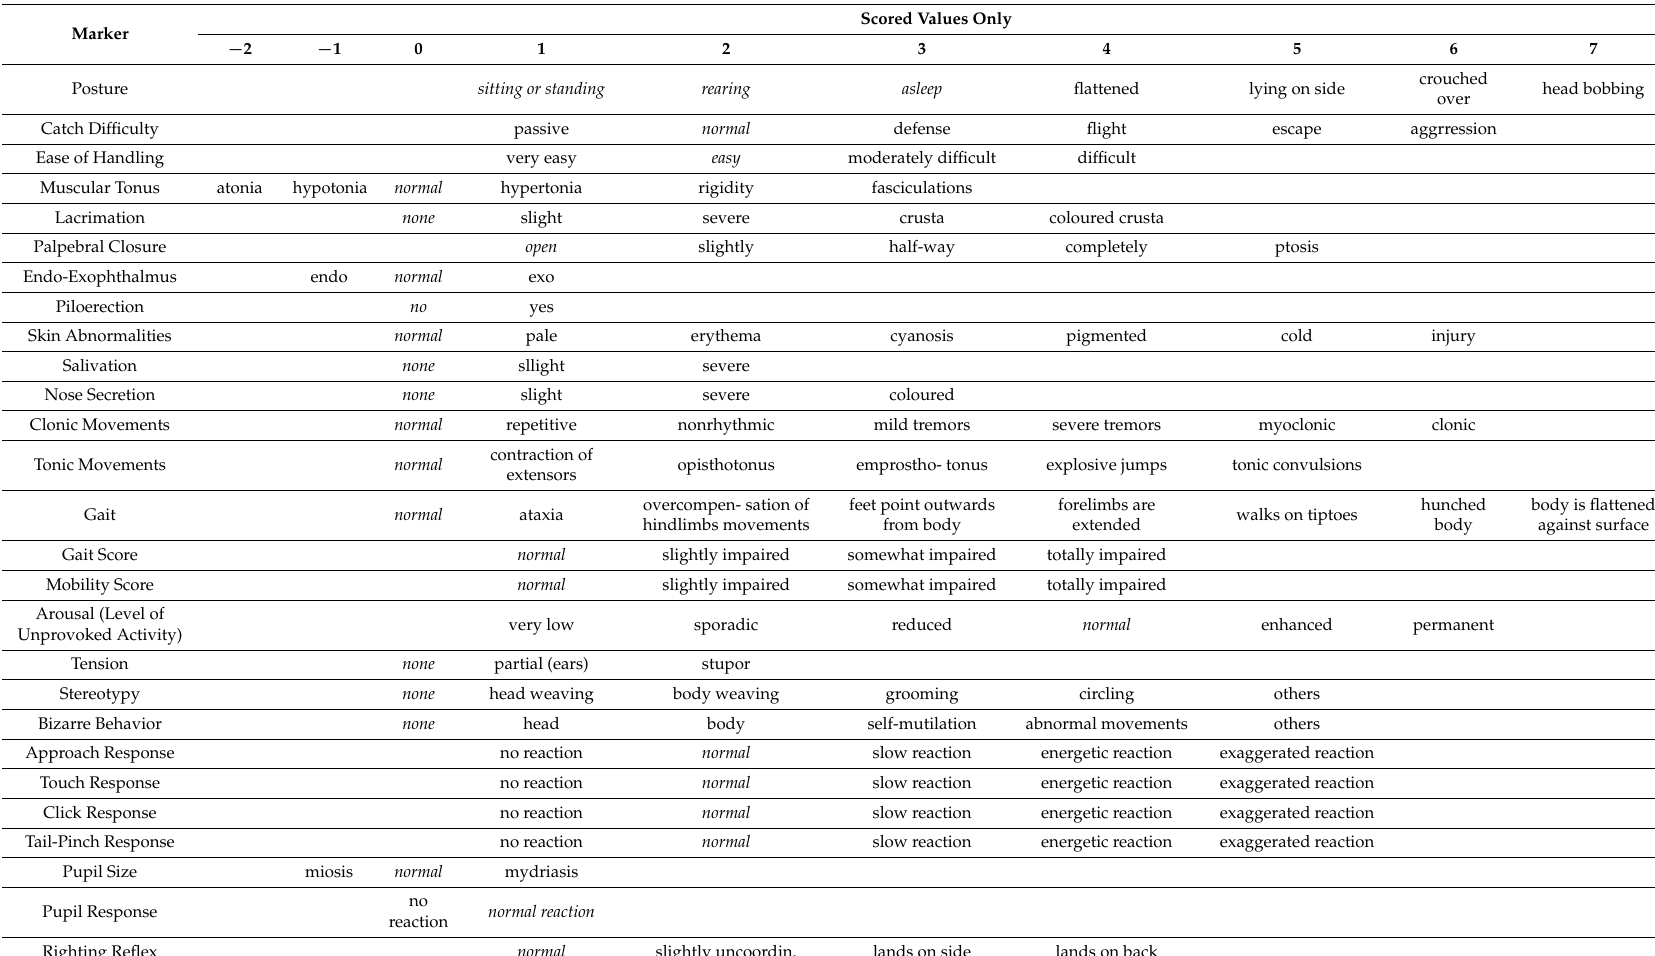
Table 6. Functional observational battery